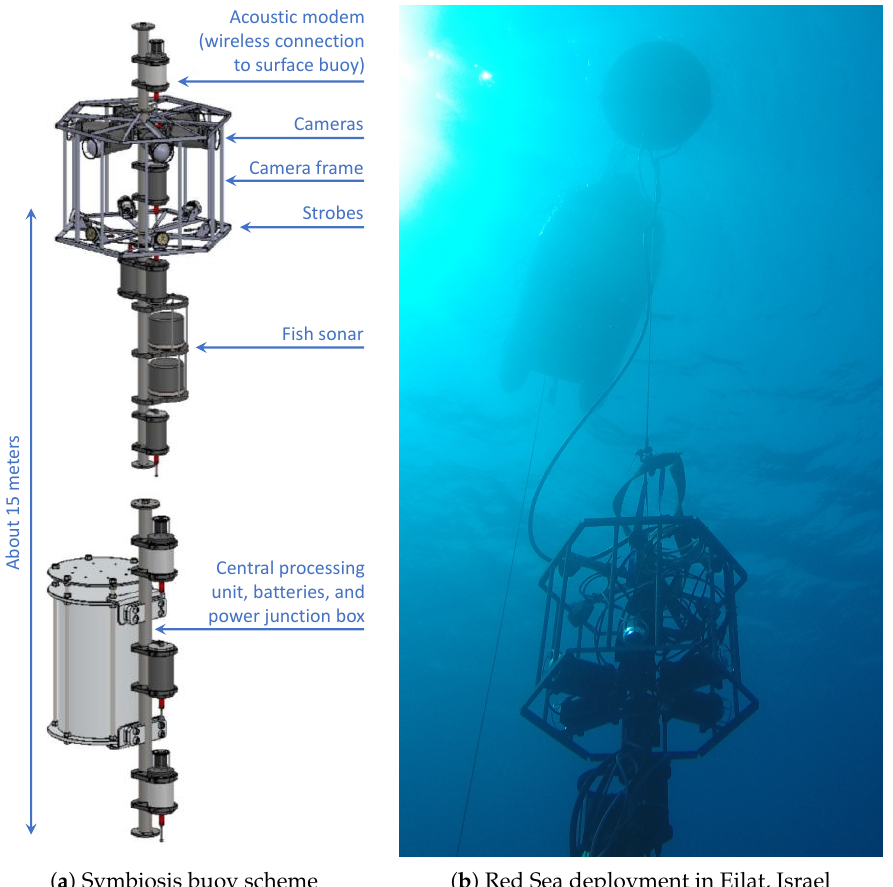
Figure 7. ( a ) A 3D view of the Symbiosis platform and its main components. The lower section, with its own sonar and camera arrays, is arranged symmetrically with respect to the central section, and is not shown here for brevity. (Adapted from [33]). ( b ) A photo of the platform’s deployment in Eilat, Israel (Red Sea), showing the surface buoy, the top camera unit, as well as part of the